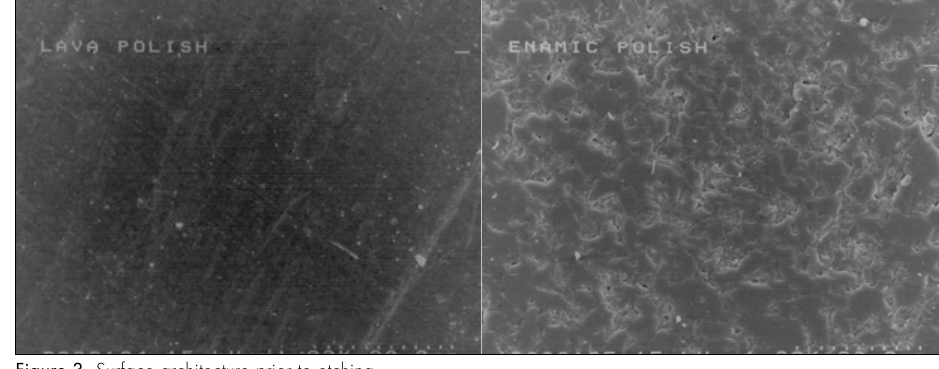
Figure 3. Surface architecture prior to etching.